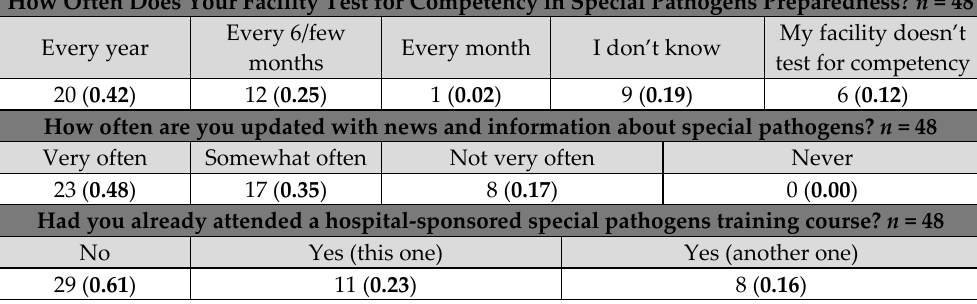
Table 1. The majority of respondents indicated that their facility tested for special pathogen pre- paredness competency every year or every 6 months and kept updated with relevant news and